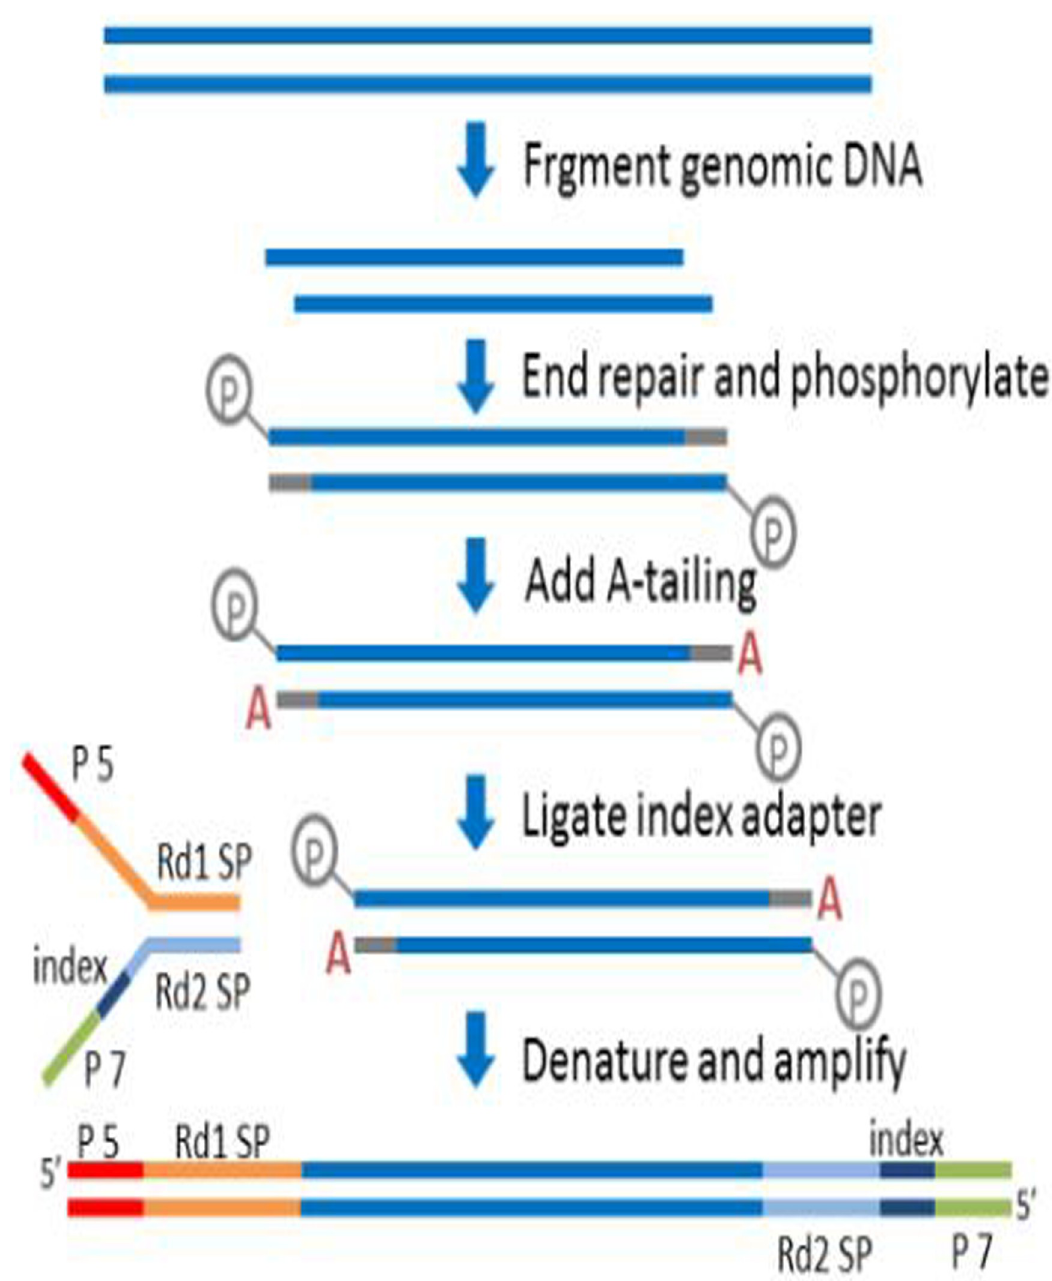
Fig 2. Library construction plot. The plot was provided by Genome Sequencing company Novogene (https://en.novogene.com).